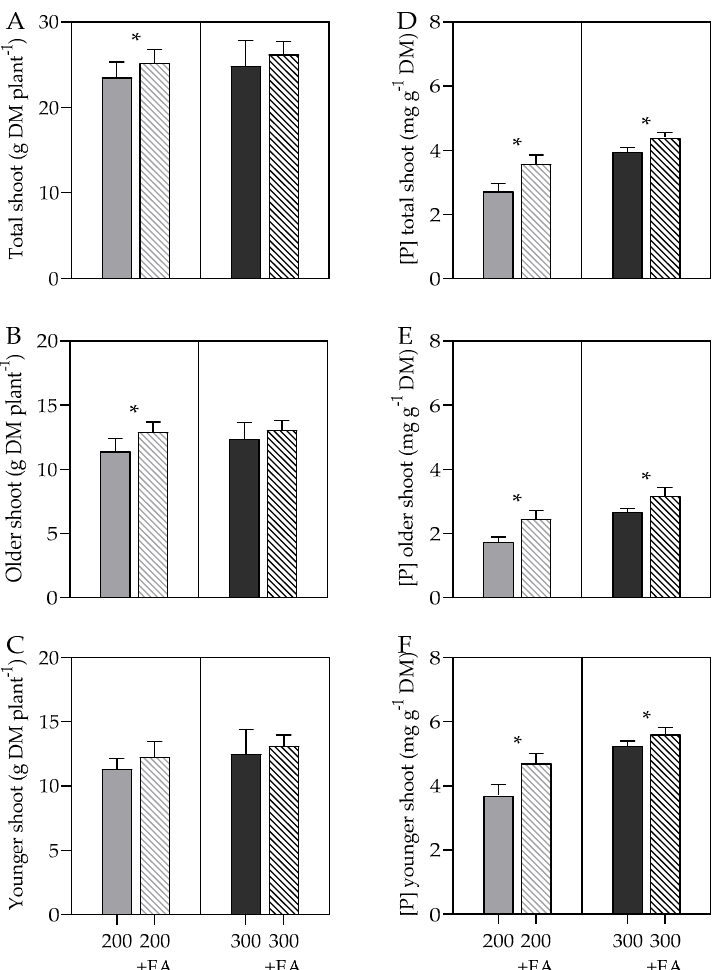
Figure 5. Dry matter in g plant − 1 and phosphorus concentration (P) in mg g − 1 dry matter of ( A , D ) total shoot, ( B , E ) older shoot, and ( C , F ) younger shoot at BBCH 16 (6th leaf unfolded). Plants were cultivated with 200 mg P soil fertilization (200) with additional foliar application (FA) (200 + FA) or with 300 mg P soil fertilization (300) with additional foliar application (300 + FA). KH 2 PO 4 was used as foliar fertilizer and was applied at 35, 42, and 49 days after sowing. Bars represent means + SD ( n = 5). Asterisks indicate significant differences between treatments of one fertilization level (student´s t-test, p ≤ 0.05).